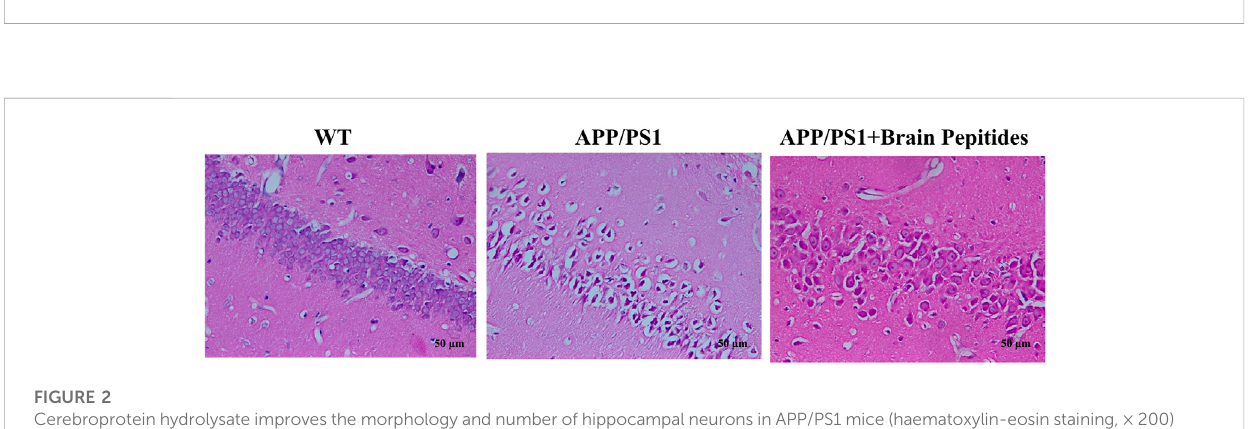
were downregulated in APP/PS1 mice compared to the model group after the administration of cerebroprotein hydrolysate (Figure 3).